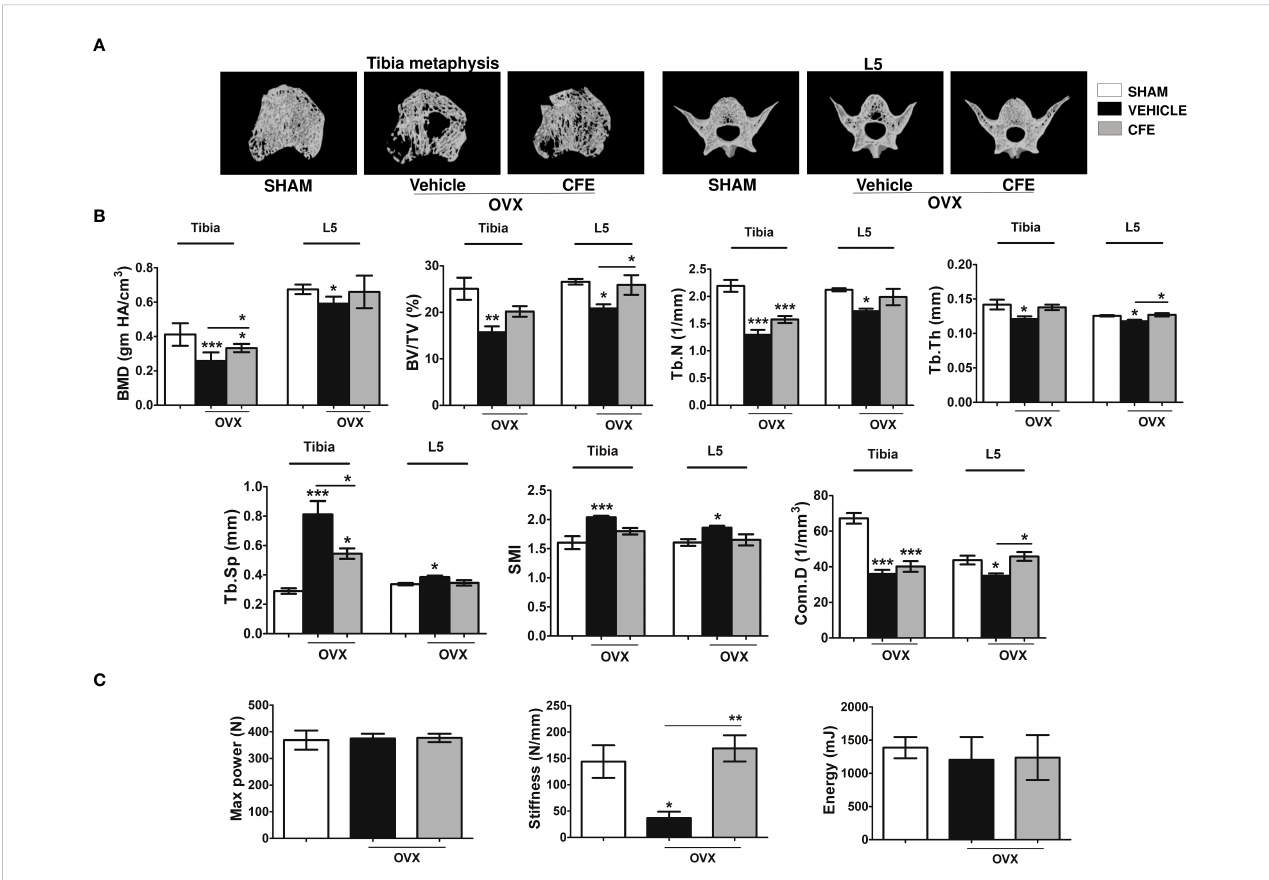
FIGURE 3 CFE prevented bone loss in osteopenic rats. (A) Representative images of tibia metaphysis, and L5 vertebrae are shown. (B) Shown are the quantitative m CT parameters of the tibia metaphyses, and L5. BMD, bone mineral density; Tb.Sp, trabecular spacing; Conn.D., connectivity density; and SMI, structure model index. (C) The L5 compression strength was determined by a bone-strength tester. All data are expressed as mean ± SEM (n = 6 bones/group); *p <0.05, **p <0.01, and ***p<0.001 vs.